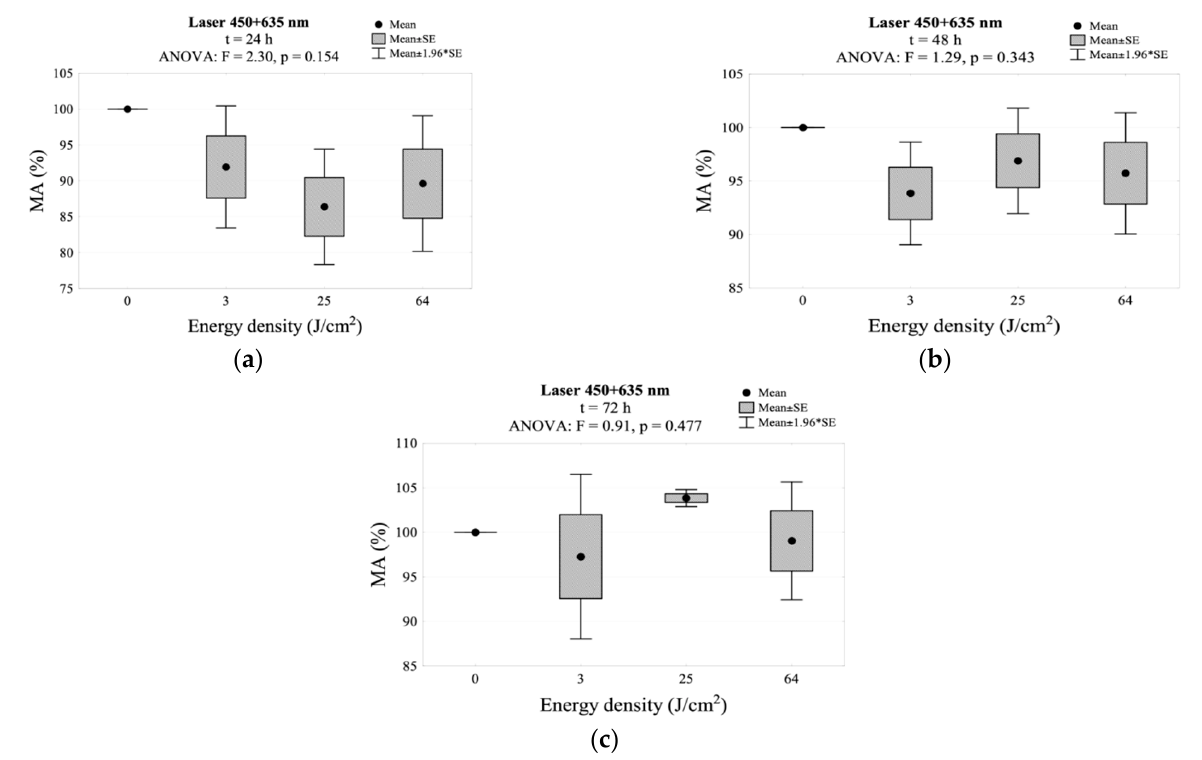
Figure 6. MA values measured: ( a ) 24 h, ( b ) 48 h, ( c ) 72 h. after irradiation using the 450 + 635 nm laser.